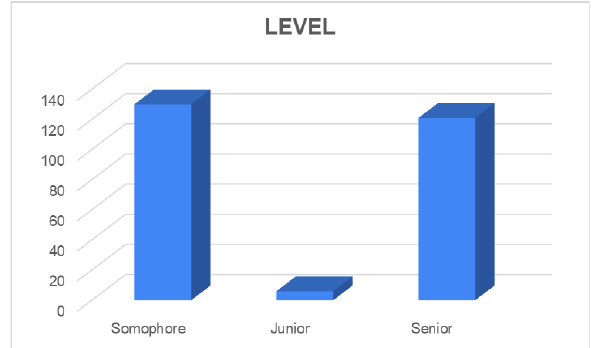
Figure 5. Level/Grade of